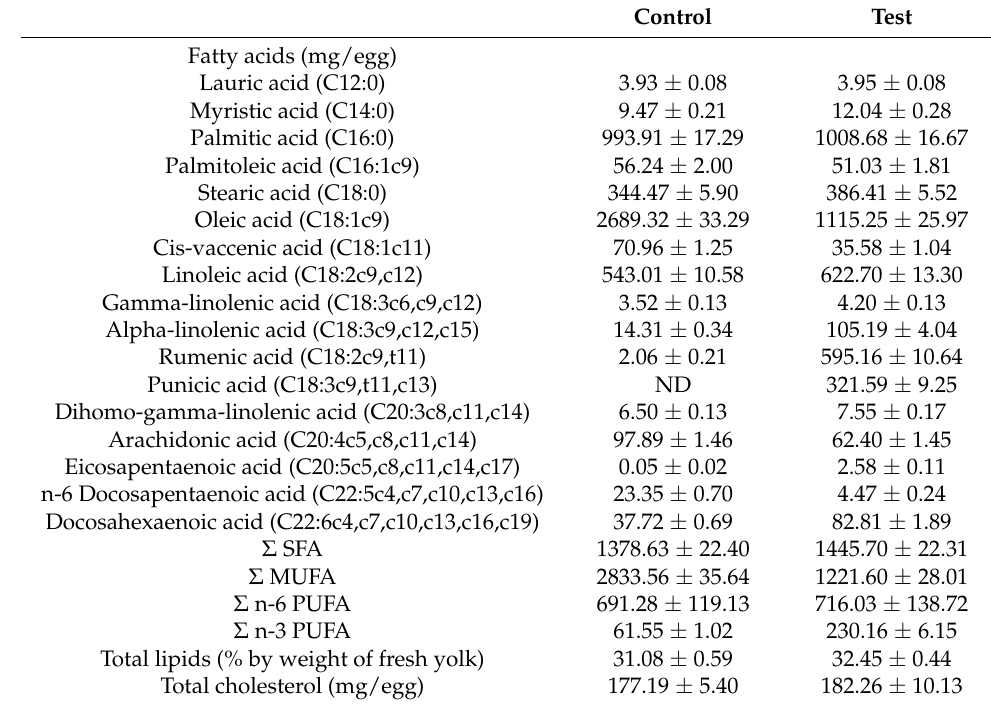
Table 1. Composition of fatty acids, total lipid, and cholesterol content of